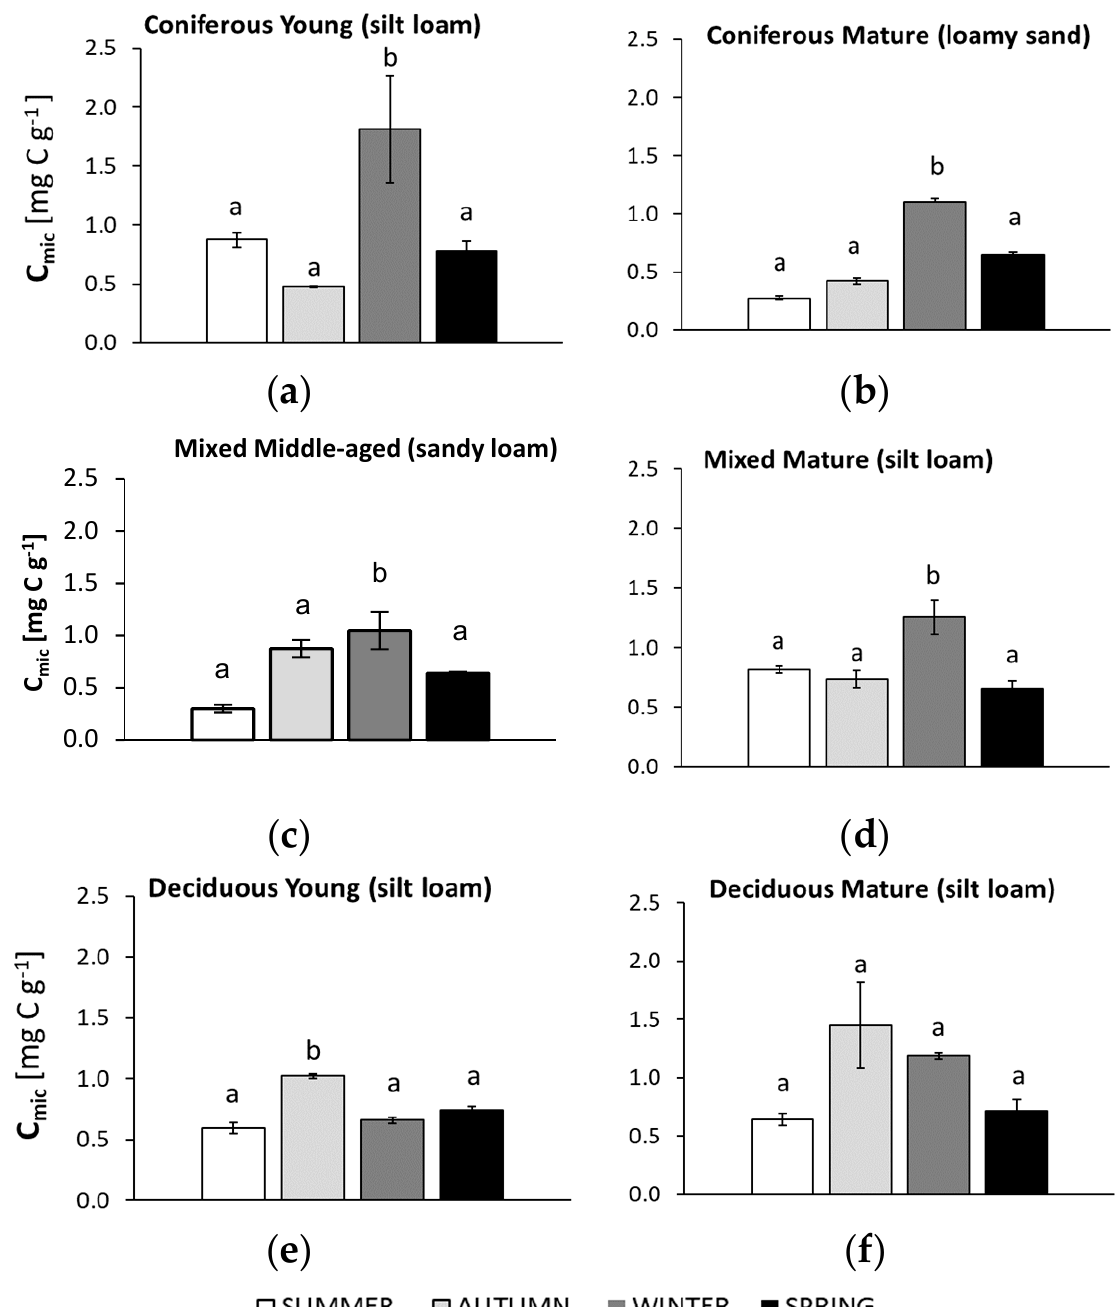
Figure 4. Soil microbial biomass (C mic ) in samples collected in summer, autumn, winter, and spring from different forests (average values ± standard deviation; n = 3). ( a ) Coniferous Young (silt loam); ( b ) Coniferous Mature (loam sand); ( c ) Mixed Middle-aged (sandy loam); ( d ) Mixed Mature (silt loam); ( e ) Deciduous Young (silt loam); ( f ) Deciduous Mature (silt loam). Different letters indicate significant differences (a non-parametric Kruskal–Wallis test, p < 0.05, was carried out separately for each season and for each forest).